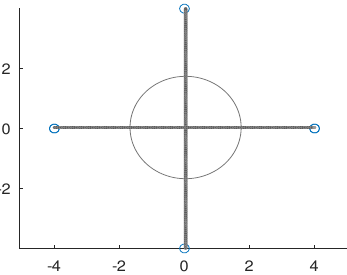
Figure 2. The validation figure of the constrained optimization problem of finding a circle in 2D that is closest to all four points, (3.58, 1.78), ( − 3.00, 2.61), (2.12, − 3.45), ( − 3.26, − 2.34) among all the circles that are constrained to pass through ( − 4, − 4) and (4, 4). The solution is the center (0.034375, 0.034375) with radius 1.7081.